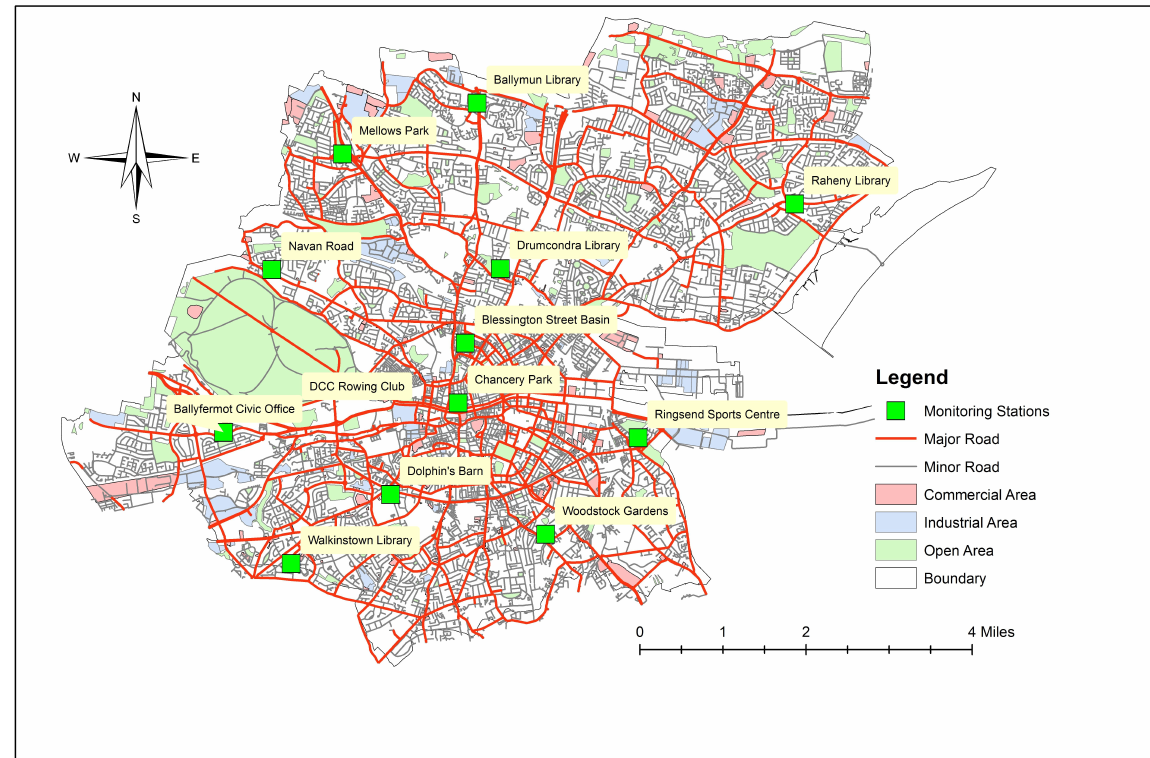
Figure 1: Dublin City Council Sound Monitoring